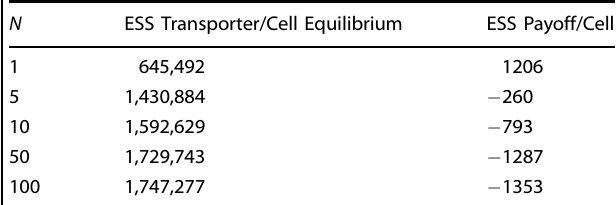
Fig. 8 Team-optimum, ESS, and sucker ’ s gambit equilibria for GLUT1 inhibitor (left) and glucose starvation (right) treatments: N = 5 case. The payoff per cell is plotted as a function of the transporters per cell. Under the sucker ’ s gambit strategy, cancer cells have a lower payoff curve per cell and produce more transporters than both the team-optimum and ESS cases. Table 5. ESS transporter equilibria and payoffs under sucker ’ s gambit Table 6. ESS transporter equilibria and payoffs under sucker ’ s gambit strategy: resource availability modi fi cation. strategy: nutrient encounter rate modi fi